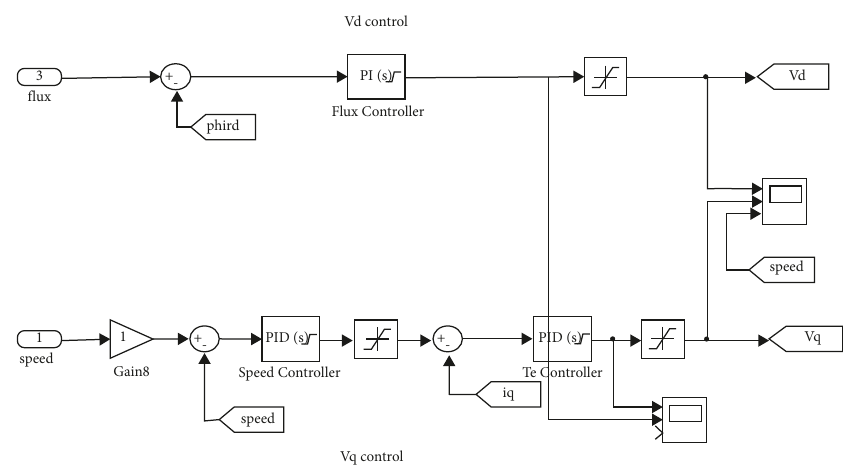
Figure 13: Te subsystem of fux and speed control.